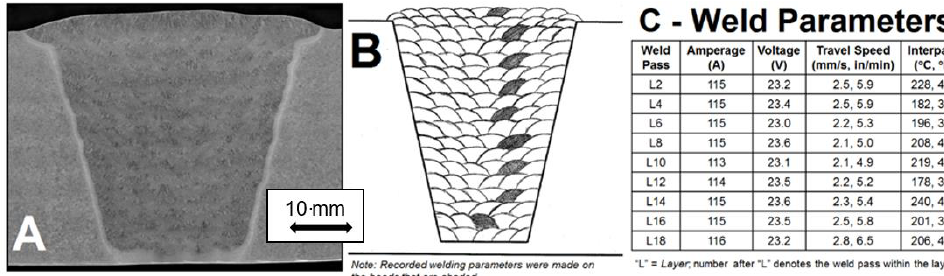
Figure 5. ( A ) Macro Sample of the As-fabricated Weldment in the Post Weld Heat Treated Condition. (675 ◦ C, 1250 ◦ F for 2 h) as shown the pipe thickness is 50 mm; ( B ) Fill Sequence used to complete the Weldment. Note that the darkened fill passes constitute a fill pass that was monitored for voltage, amperage, travel speed and interpass; ( C ) Details for the Monitored Fill